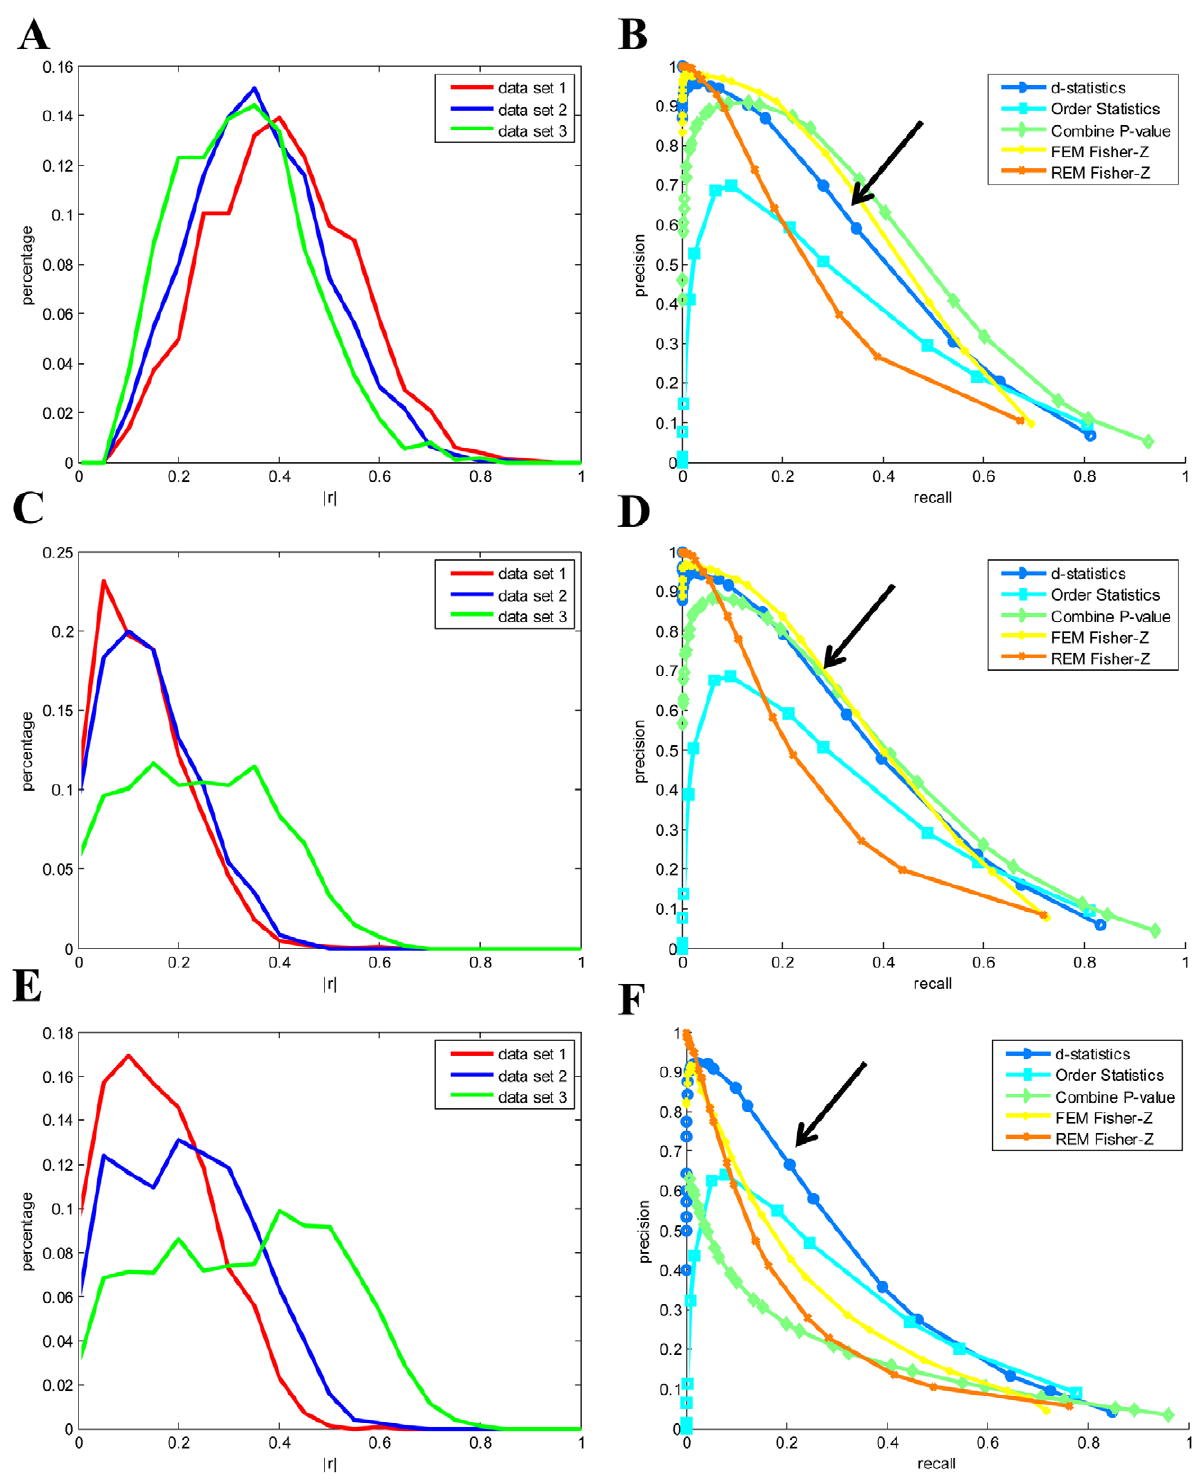
Figure 2. Performance comparison of different meta-analysis methods under different noise conditions. (A) the signal strengths (measured by the correlation between the latent regulators and their downstream genes); (B) the performances of different methods when there was no systematic noise; (C) moderate systematic noises (measured by the correlation between genes and systematic noises); (D) the performances of different methods when the systematic noises were as shown in (C); (E) stronger systematic noises than (C); (F) the performances of different methods when the systematic noises were as shown in (E). FEM Fisher-Z: the fixed effect model based on Fisher-Z transformation; REM Fisher-Z: the random effect model based on Fisher-Z transformation; Combine P-value: combine p-values of Fisher’s Inverse x 2 tests; Order Statistic: Order-based non- parametric meta-analysis; d-statistics: the semi-parametric meta-analysis. See Materials and Methods section for details of individual methods.